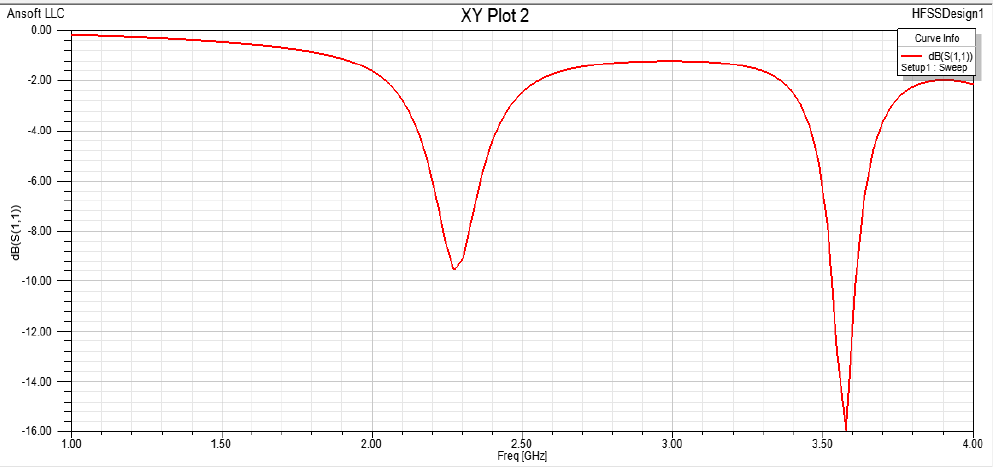
Fig. 5. Return loss of Final Antenna.